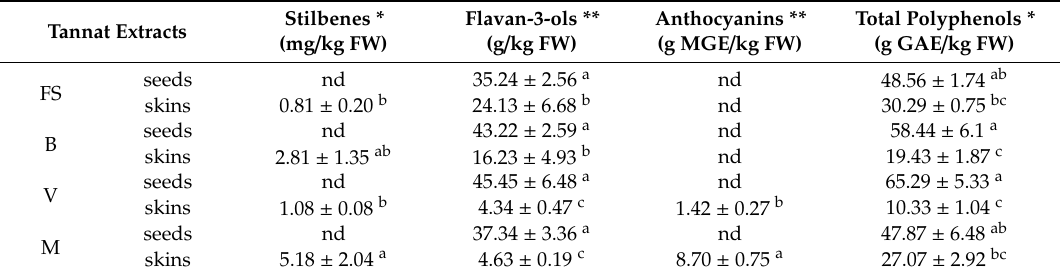
Table 1. Total polyphenolic content of skin and seed Tannat grapes at di ff erent ripening stages: First Stage (FS), Before Veraison (BV), Veraison (V) and Maturity (M). Stilbenes * Flavan-3-ols ** Anthocyanins ** Tannat Extracts (mg / kg FW) (g / kg FW) (g MGE / kg